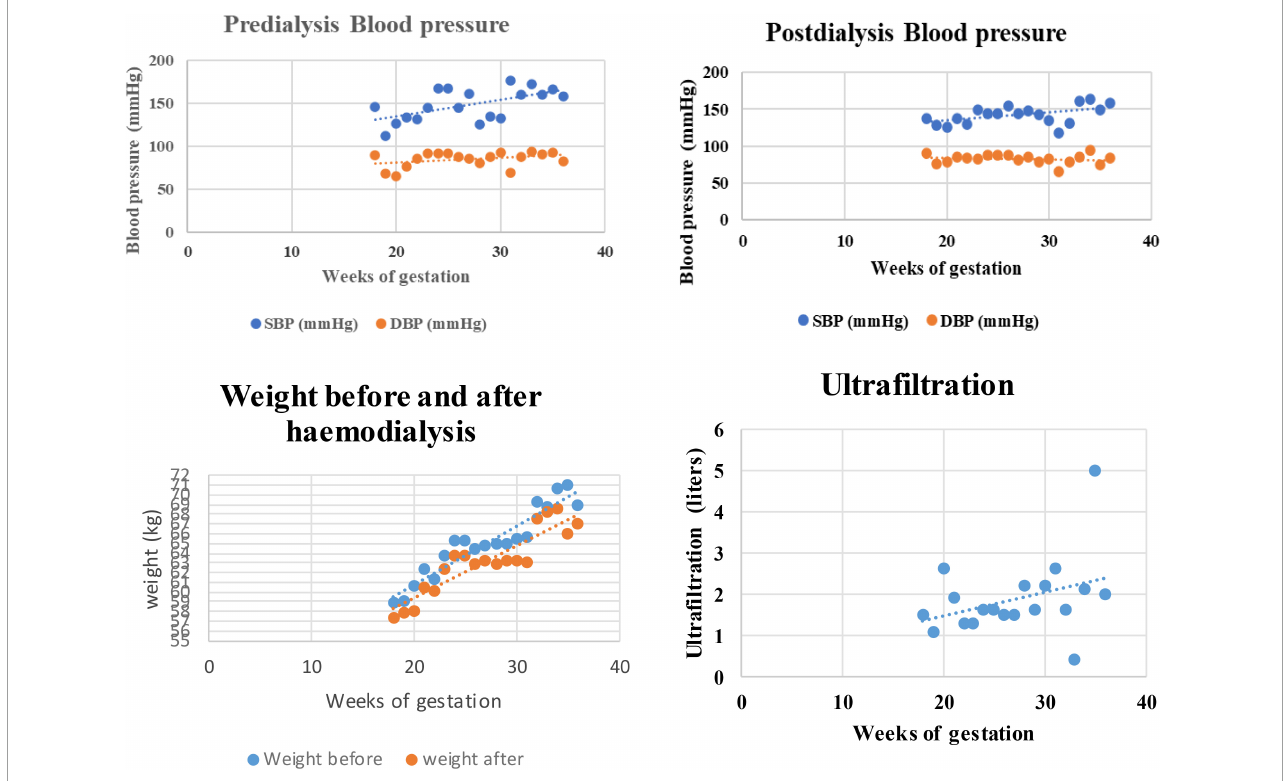
FIGURE1 Blood pressure, weight, and ultrafiltration with the gestational age of the mother.